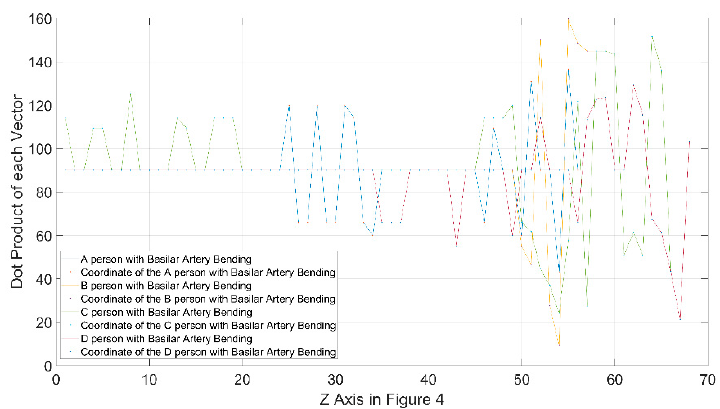
Figure 5. Graph showing bending degree of basilar artery calculated as dot product of vector (size).